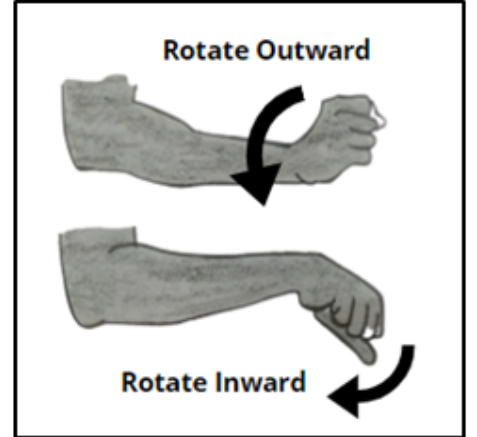
Figure-VII: Illustration of rotating wrist clockwise (outward) and anticlockwise (inward).